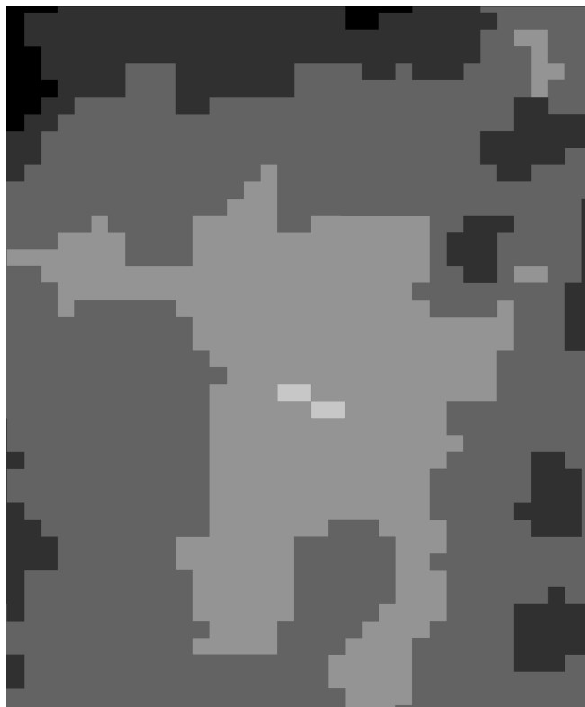
Figure 8. Pleiades satellites orthophoto of the defunct church